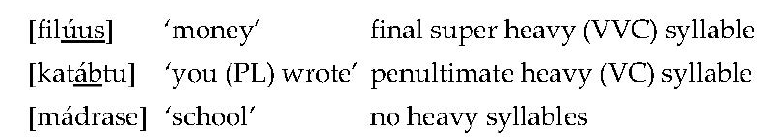
Figure 2. Tunisian Arabic syllable weight.